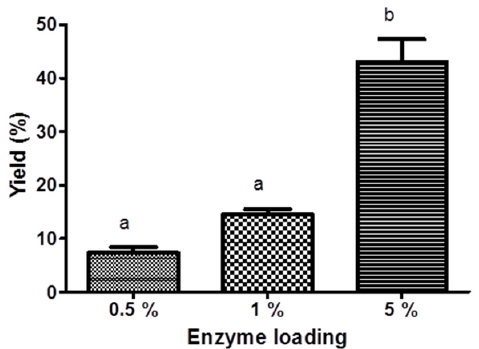
Figure 3. The effect of enzyme loading on 7- O -kojic acid monopalmitate synthesis in solvent-free system at 240 min using Novozyme 435 at 70 °C. Data are presented as means ± S.E.M, n = 3. The letters a and b indicate significant difference at p < 0.05 with Bonferroni’s Multiple Comparison Test.